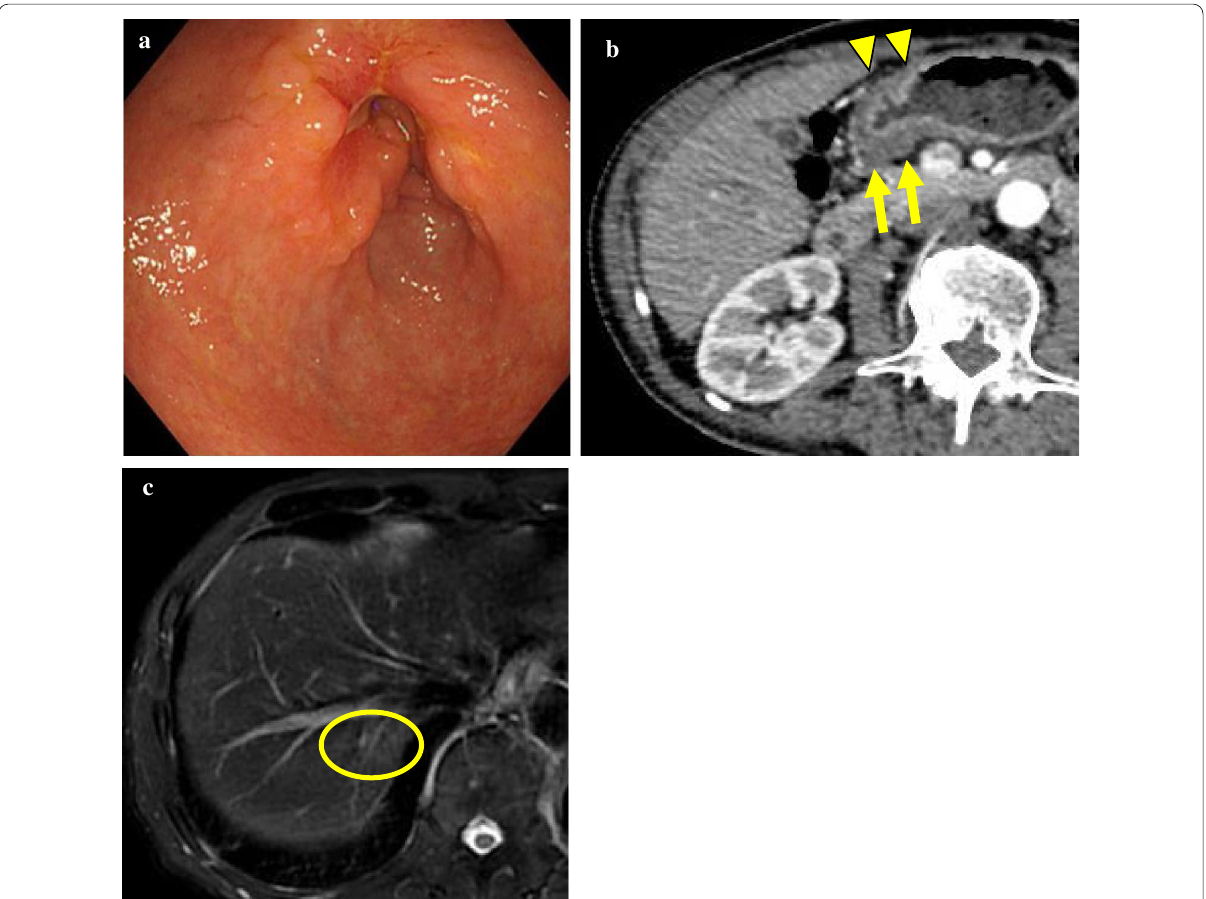
Fig. 3 Image findings after preoperative chemotherapy. a Upper gastrointestinal endoscopy showed marked shrinkage of the primary tumor. b On CT, shrinkage of the primary tumor (triangle) and regional lymph nodes (arrow) was confirmed. c MRI showed marked shrinkage of liver metastasis